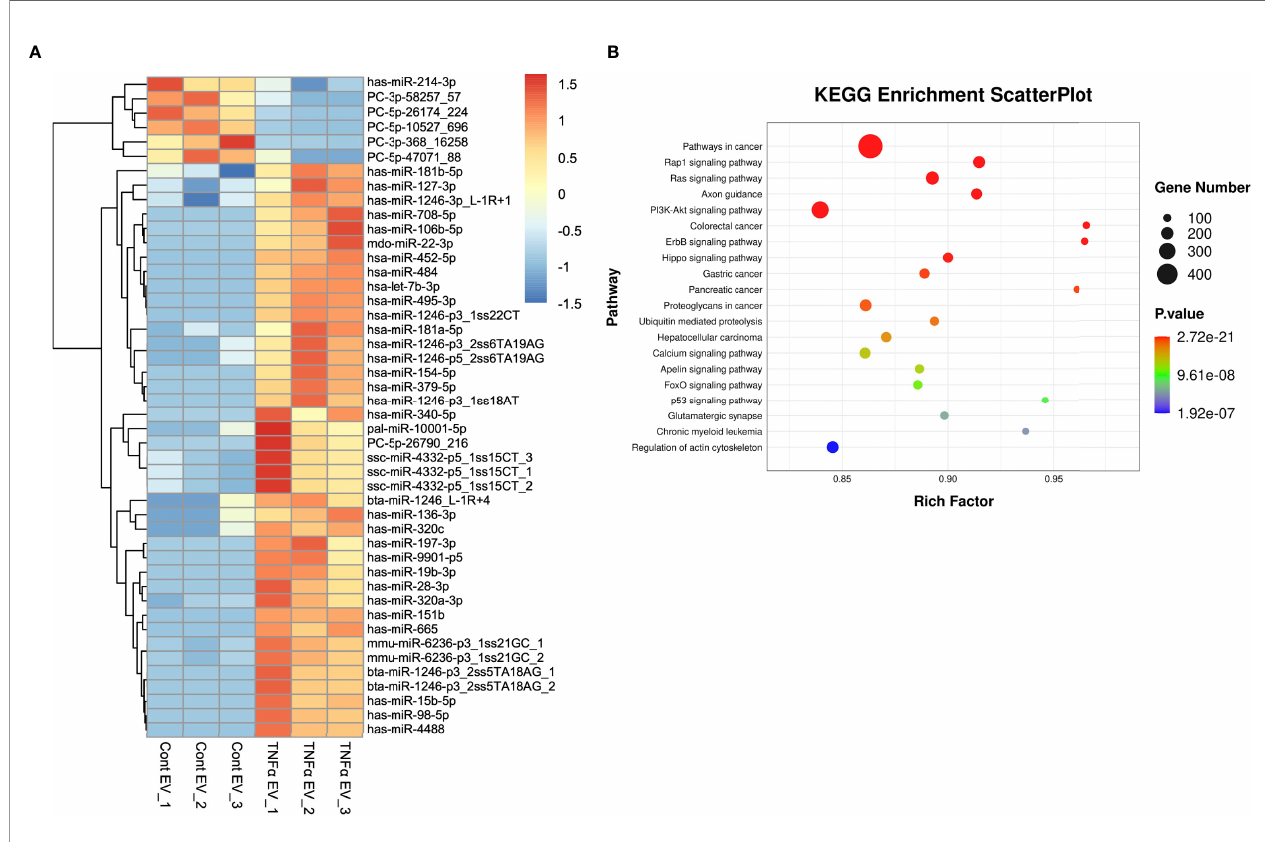
FIGURE 8 | miRNA components in TNF a EVs. (A) A heat map of the differentially expressed miRNAs in control and TNF a EVs (n = 3). (B) KEGG analysis of relevant pathways signi fi cantly affected by differentially expressed miRNAs in TNF a EVs. Statistical signi fi cance (P < 0.05) was determined by performing Fisher ’ s exact